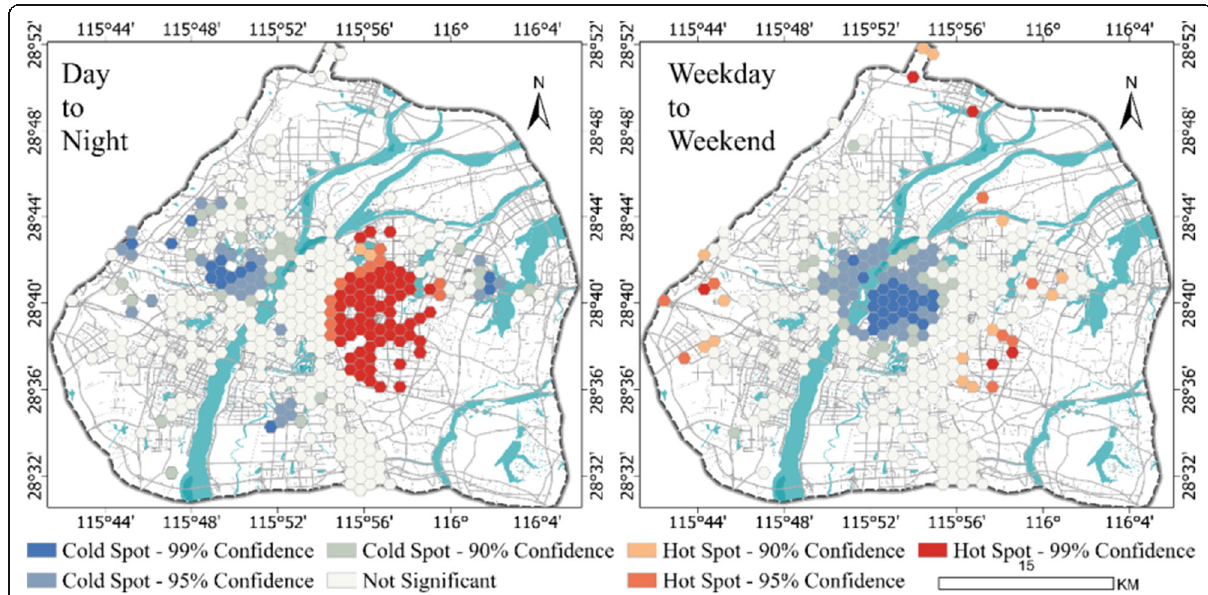
Fig. 8 Spatial distribution of hot spots (cold spots) of emotional volatility. The left figure shows the hot spots of the relative length of the time path of emotions from day to night, and the right figure shows the hot spots of the relative length of the time path of emotions from weekday to weekend